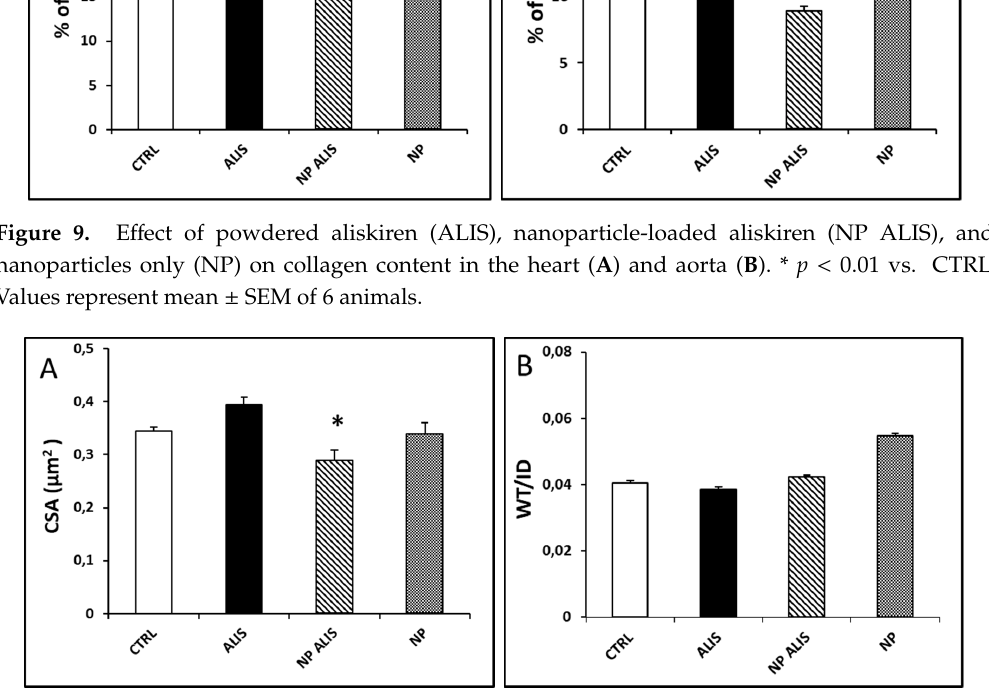
Figure 10. Effect of powdered aliskiren (ALIS), nanoparticle-loaded aliskiren (NP ALIS), and nanoparticles only (NP) on cross sectional area (CSA) ( a ) and wall thickness – inner diameter ratio (WT/ID) ( b ) of the aorta. * p < 0.01 vs. CTRL; Values represent mean ± SEM of 6